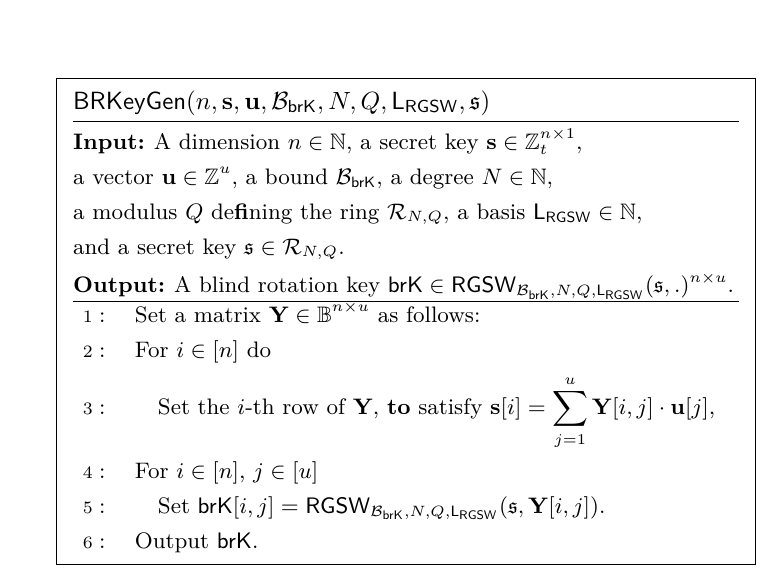
Figure 10: Blind rotation setup